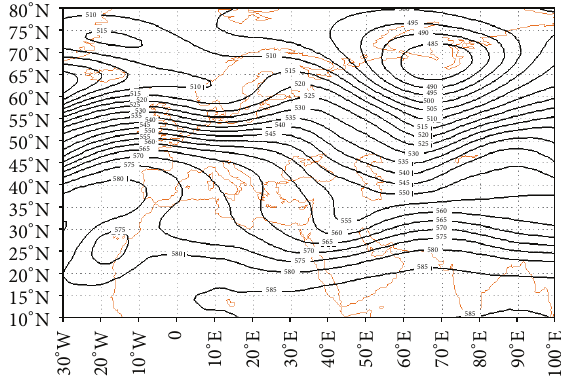
Figure 16: 500HPa geopotential height level map.